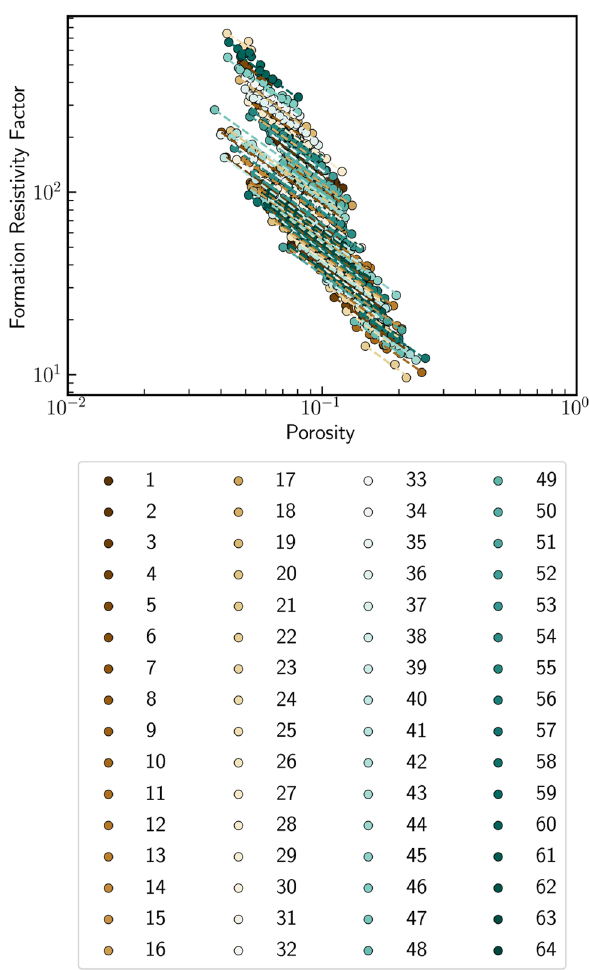
Fig. 8 Log–log plot of a versus average EQI for each ERT: a sand- stones, b carbonates Table 7 Evaluation report for testing